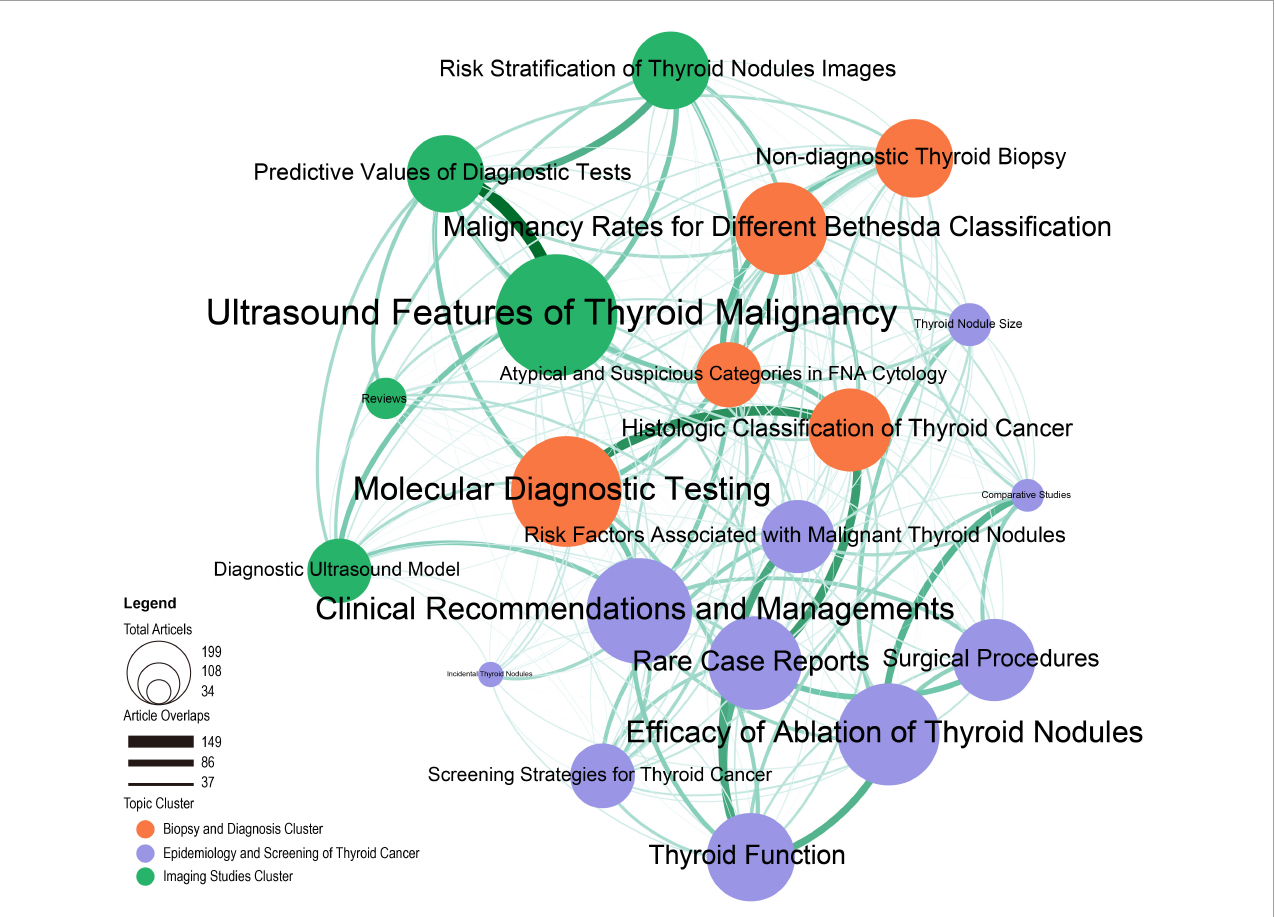
FIGURE7 The Latent Dirichlet allocation (LDA) research topic cluster network: inter-and